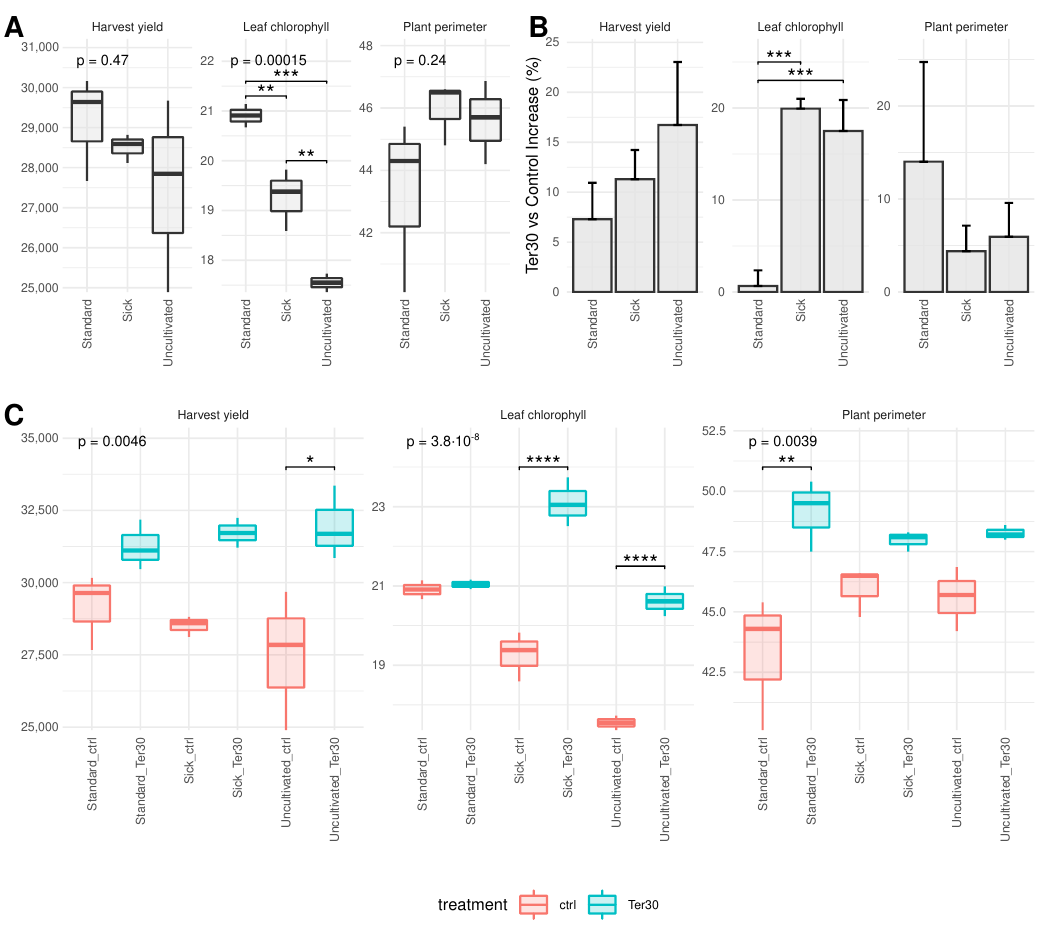
Figure 1. Harvest yield (kg ha − 1 ), leaf chlorophyll content (CCI), and plant perimeter (cm) phenotype comparison ( A ). Plant phenotype indicators comparison among different soil types without treatment ( B ). Percentage of phenotype expression increases after treatment with Terramin R (cid:13) Pro at 30 L ha − 1 respect to the control condition ( C ). Phenotype comparison after treatment with Terramin R (cid:13) Pro at 30 L ha − 1 compared to the control condition. p -values shown in the top of panel A and B indicate the resulting ANOVA significance. In Panel C, note that only statistical differences among treated and control for the same soil type are shown. Significant statistical differences between groups ( A , B ) or pairwise ( B ) are indicated as follows: * ( p -value < 0.05), ** ( p -value < 0.005), *** ( p -value < 0.0005), **** ( p -value <